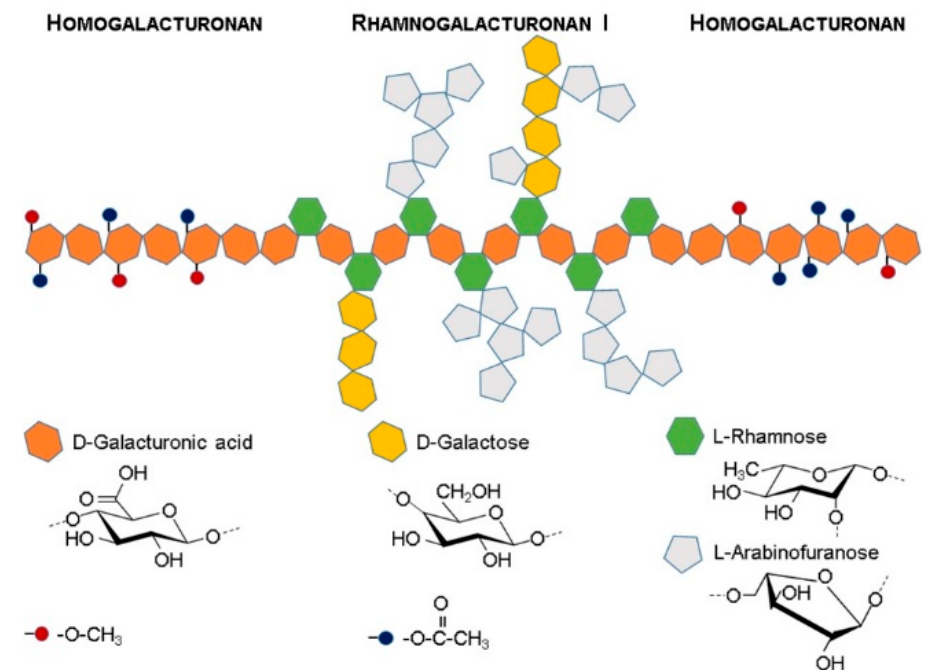
Figure 3. Schematic model of citrus fruits’ pectin block copolymer structure, illustrating its two major components: Homogalacturonan and rhamnogalacturonan I.